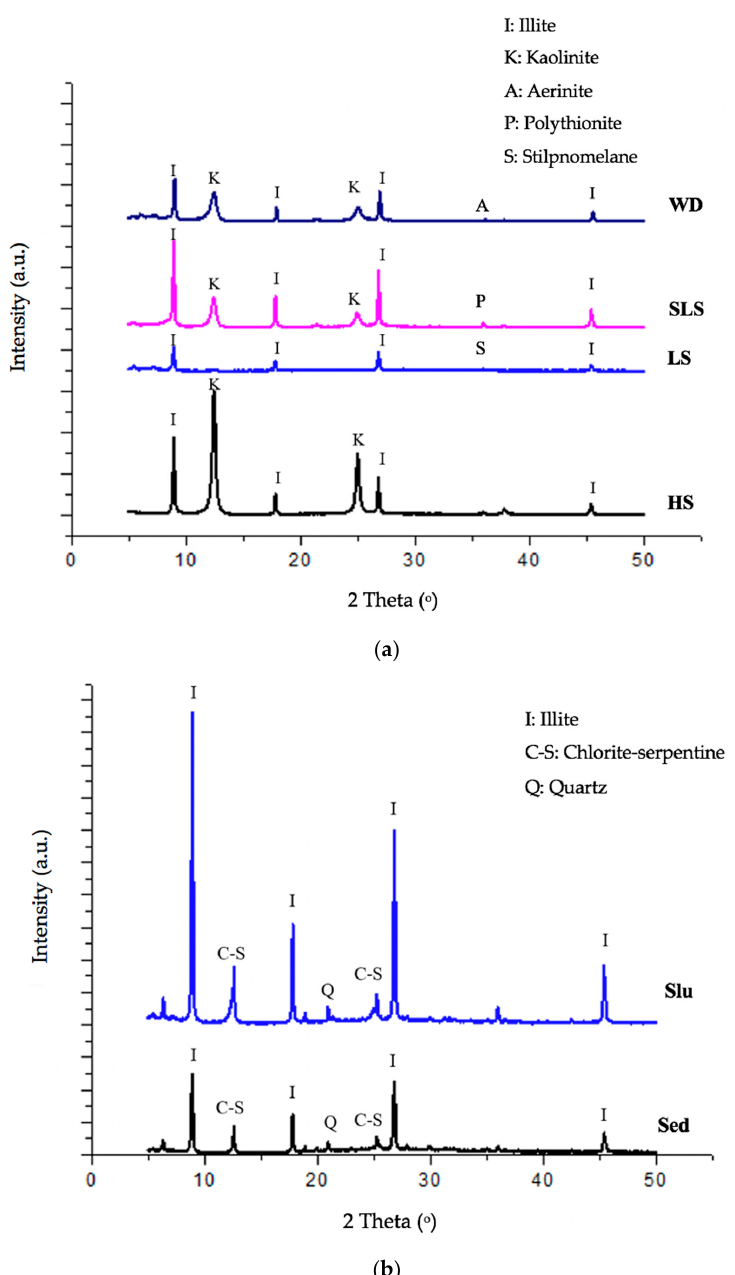
Figure 3. X-ray diffractograms of ( a ) soils in waste dump and stockpiles ( b ) sediment and sludge of mine tailings.